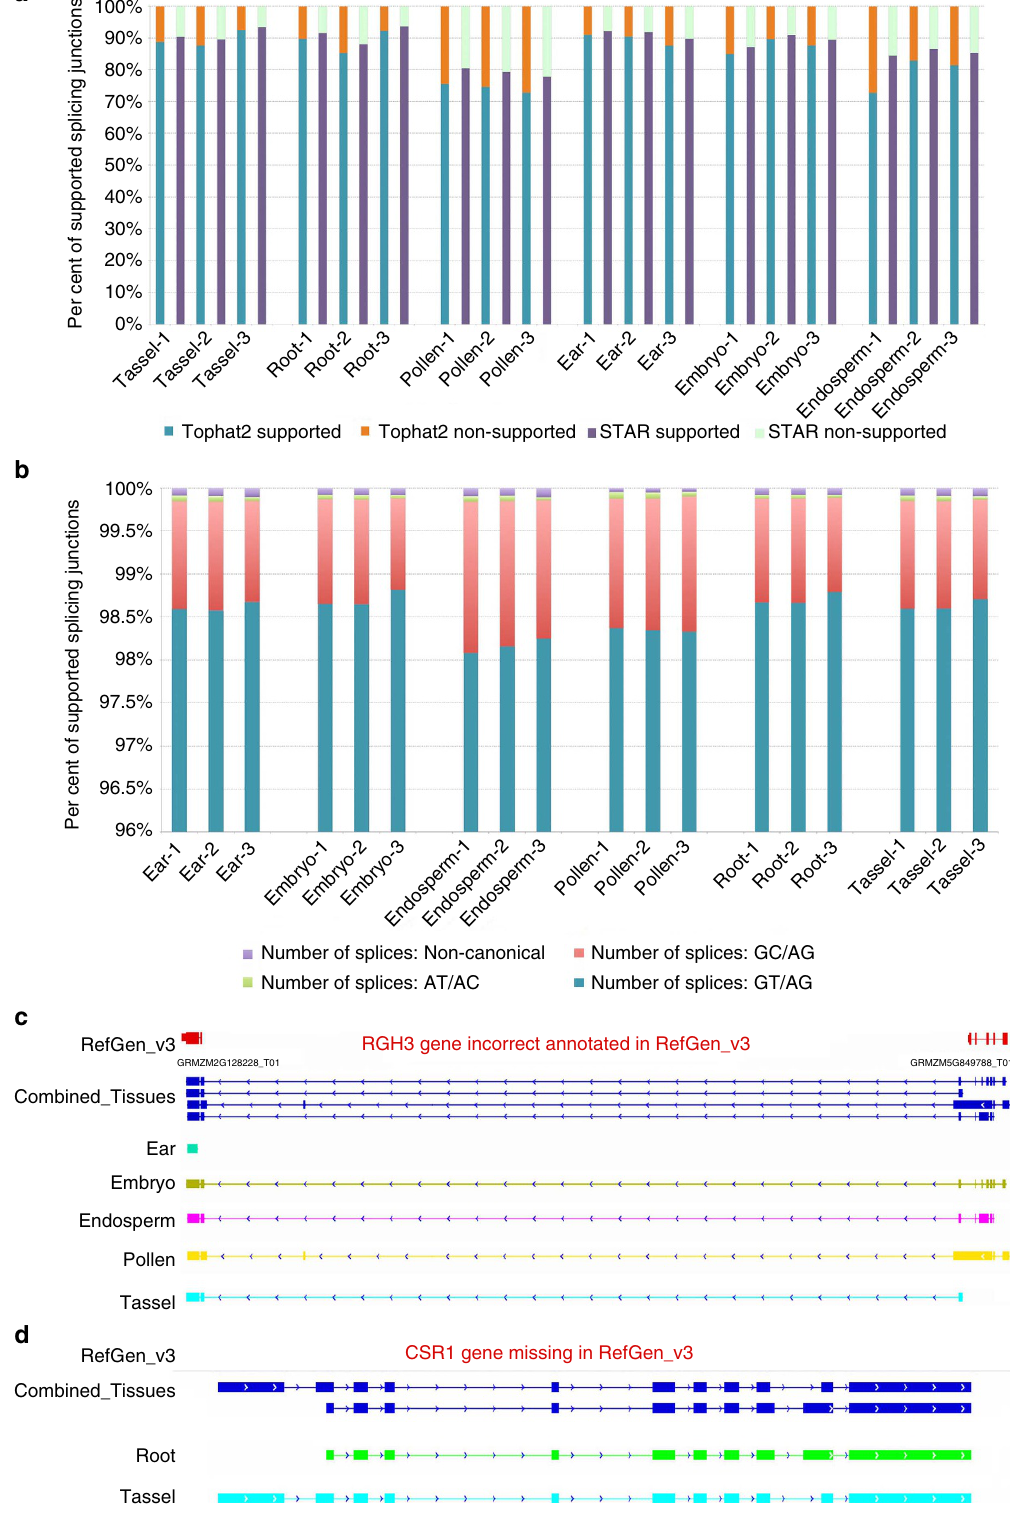
Figure 5 | Validation of PacBio isoforms. ( a ) Verification of PacBio isoform junctions by short-read junction using TopHat2 and STAR. ( b ) Splicing motif distribution of short-read mapping by STAR. ( c ) The previously corrected RGH3 gene model was found in the Iso-Seq data. ( d ) The previously missed CSR1 gene model was found in the Iso-Seq NCBI’s Sequence Read Archive, which investigated tissues of leaf, (Supplementary Fig. 21a). To facilitate graphical interpretation of relatedness among different tissues, we compared our results with shoot, shoot apical meristem and seedling. Hierarchical clustering of the expression profiles revealed that pollen was most dissimilar four other available tissue-specific RNA-seq data sets 2,42 from